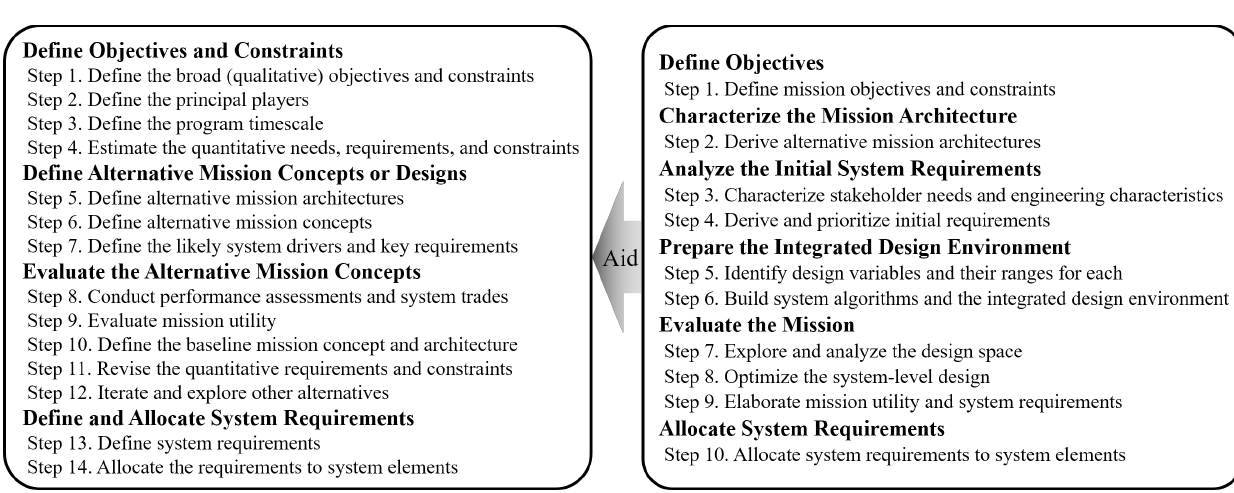
Figure 1. Generic SMAD process [3] ( left ) and proposed SMAD process ( right ).